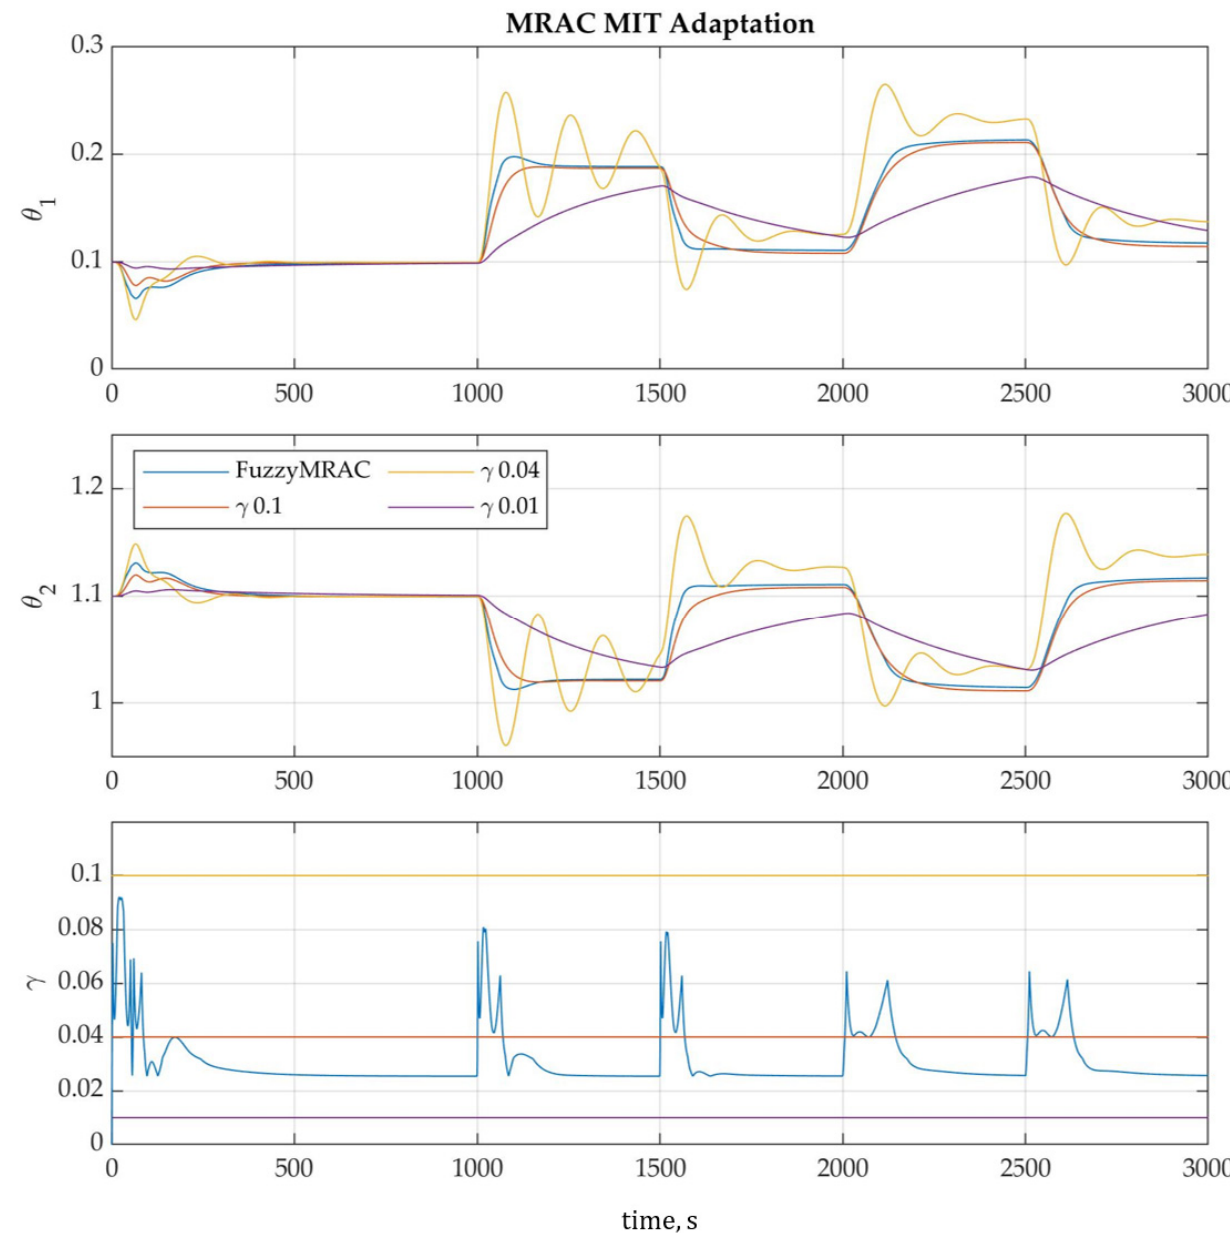
Figure 9. MIT rule fuzzy MRAC, MRAC (adaptation rate 0.01, 0.04 and 0.1) parameter adaptation θ 1 , θ 2 , and γ .